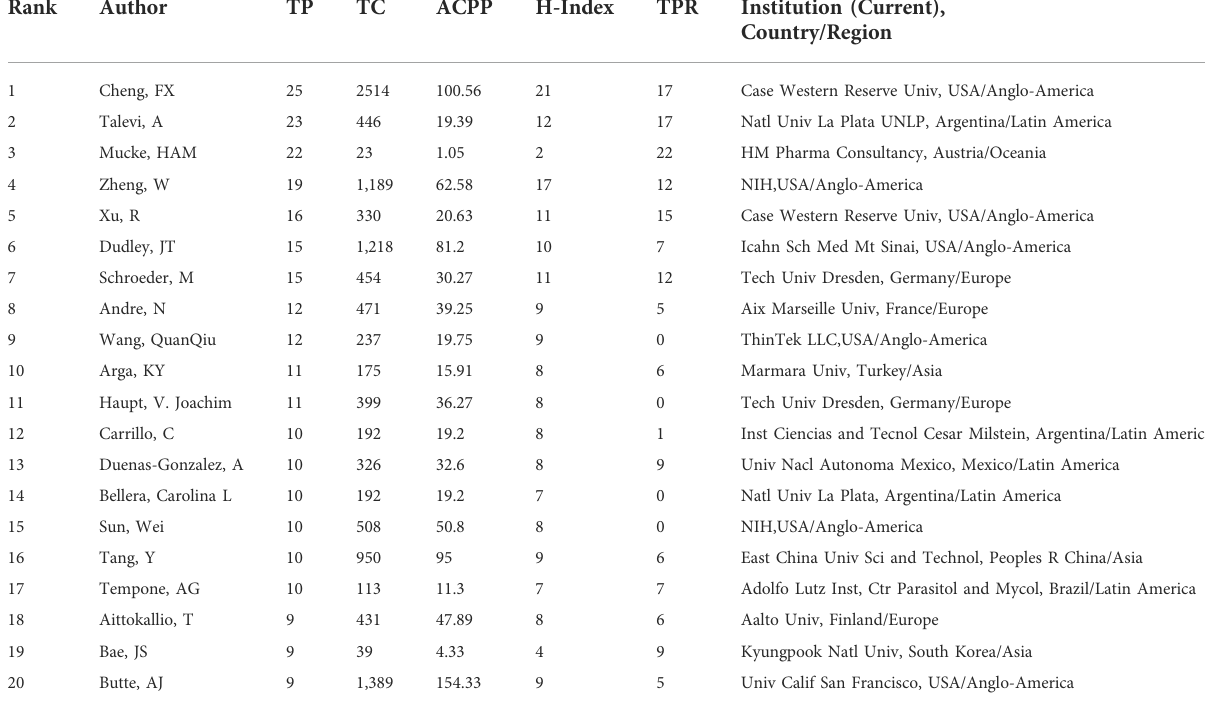
TABLE 5 Contribution of the top 20 authors to drug repurposing